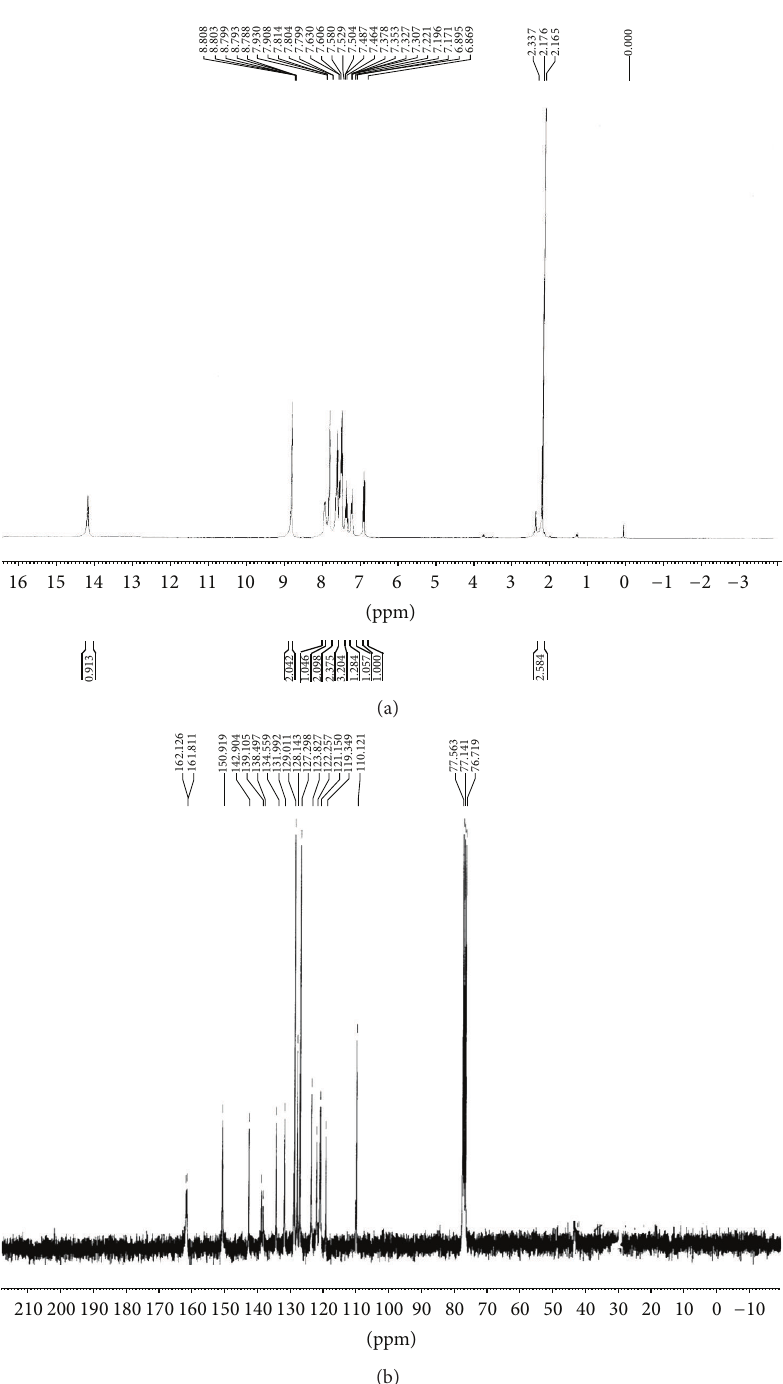
Figure 1: (a) 1 H NMR spectrum and (b) 13 C NMR of